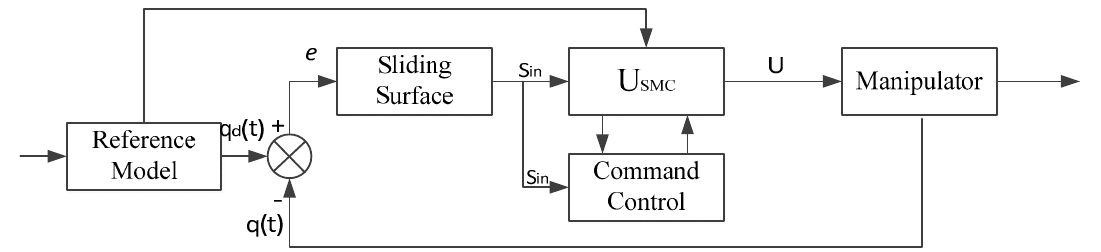
Figure 8. Structural diagram of the sliding-mode control (SMC) controller.